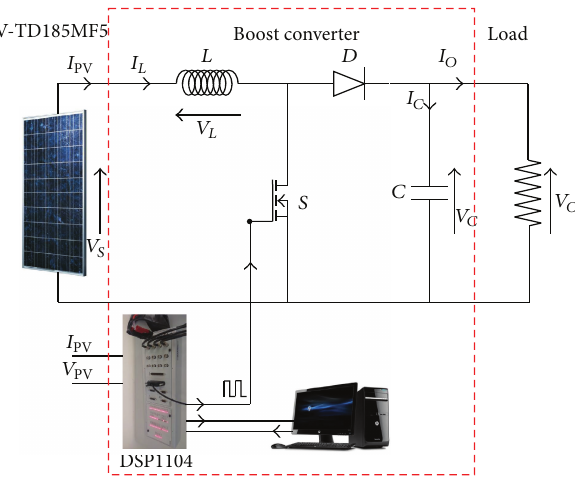
Figure 19: Temperature (step) and irradiance (constant) input values.